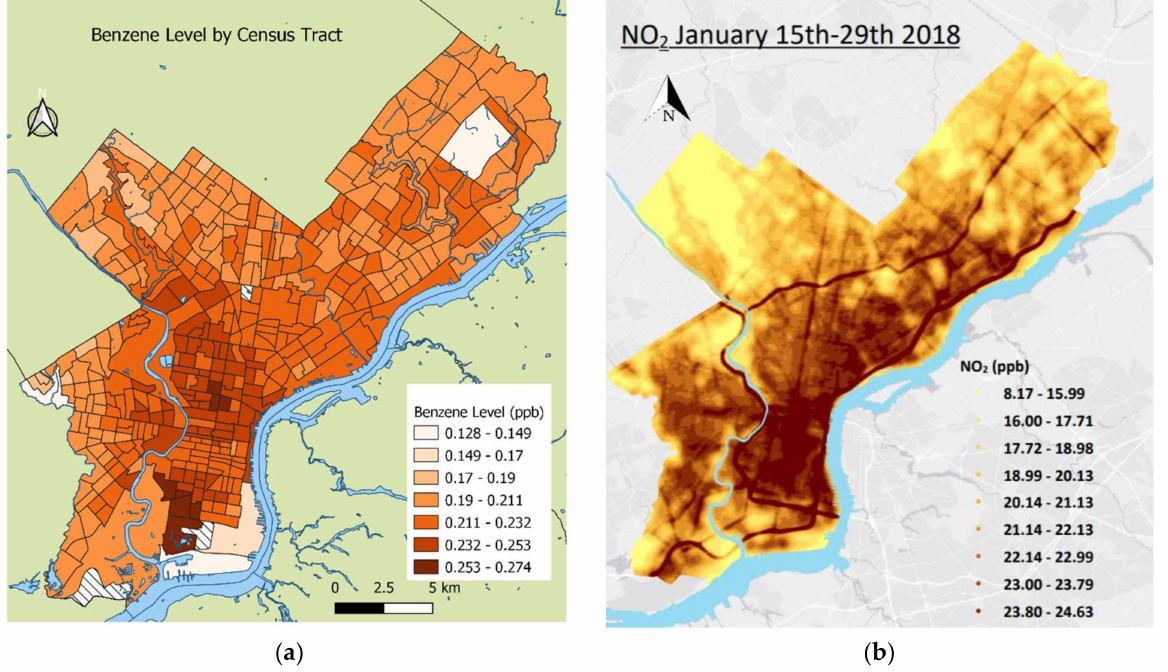
Figure 2. ( a ) Benzene level by census tract in Philadelphia County; ( b ) spatial component of LUR model showing NO 2 . This map does not account for temporal component, which is individualized to the